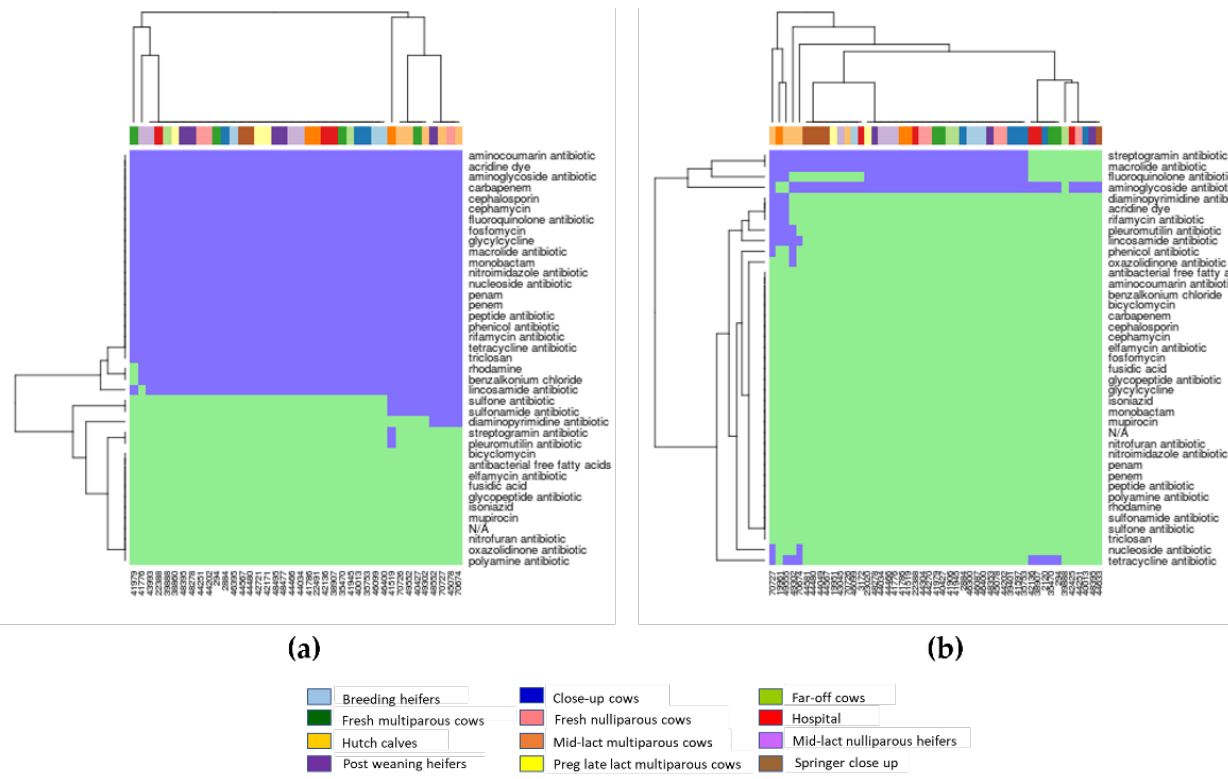
detection (light blue color in the plot area) and non-detection of (light green color in the plot area) of resistance genes from the ResFinder database. Vertical axis is antimicrobial classes, and horizontal axis is cattle IDs: ( a ) E. coli ; ( b ) Enterococcus .